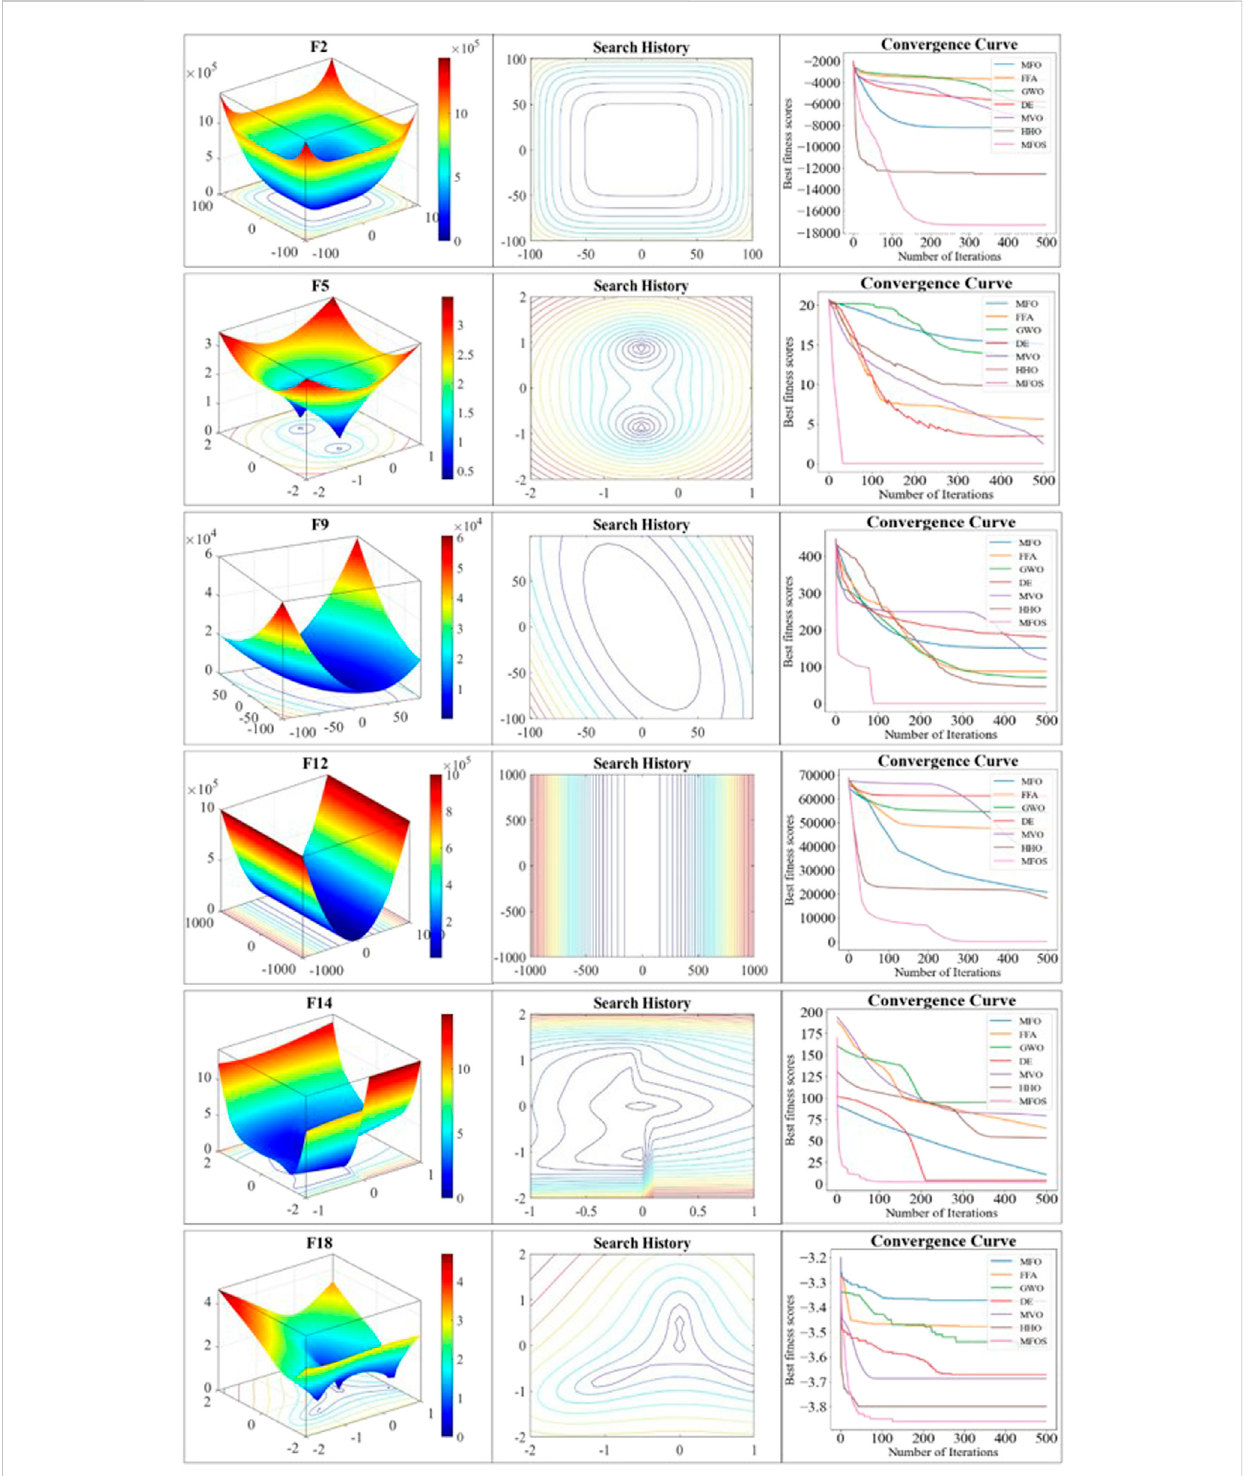
FIGURE 3 Convergence ef fi ciency of unimodal (F2 and F5), multimodal (F9 and F12), and composite (F14 and F18) functions with 3D search space, search history, and